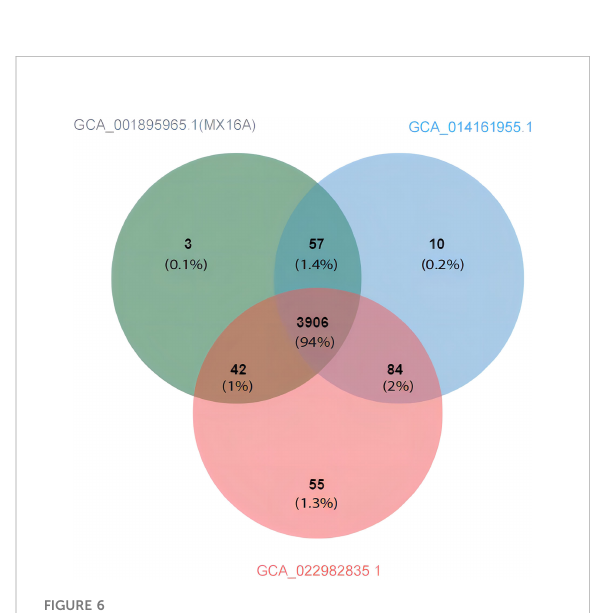
FIGURE 6 Venn diagram showing the protein shared and exclusive among A. hydrophila GCA_001895965.1 (MX16A), GCA_014161955.1, and